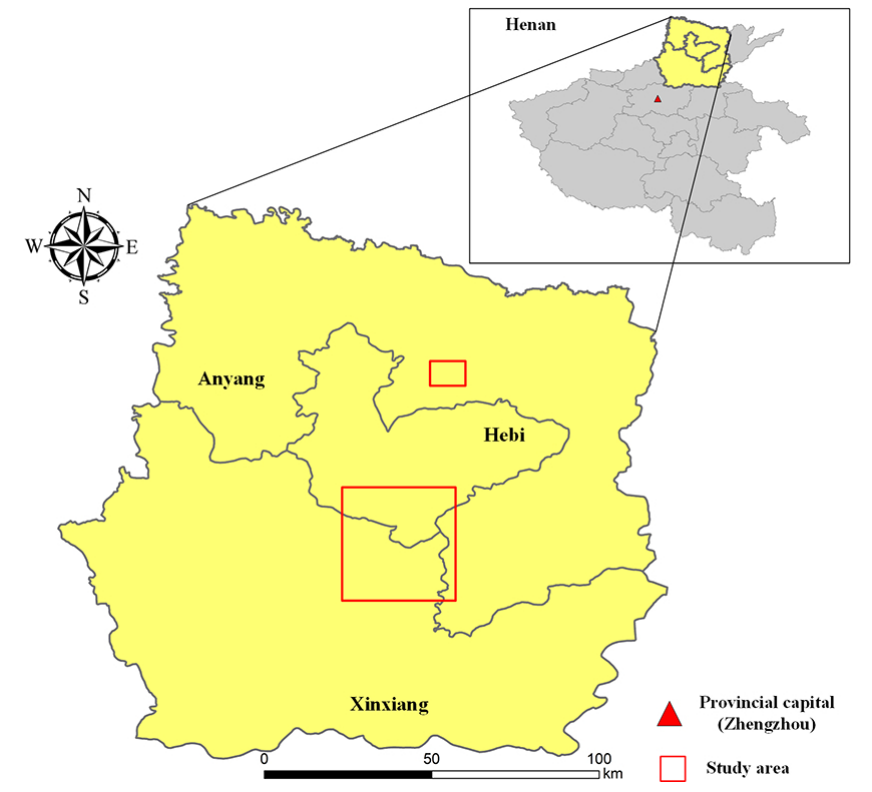
Figure 3. Locations of study